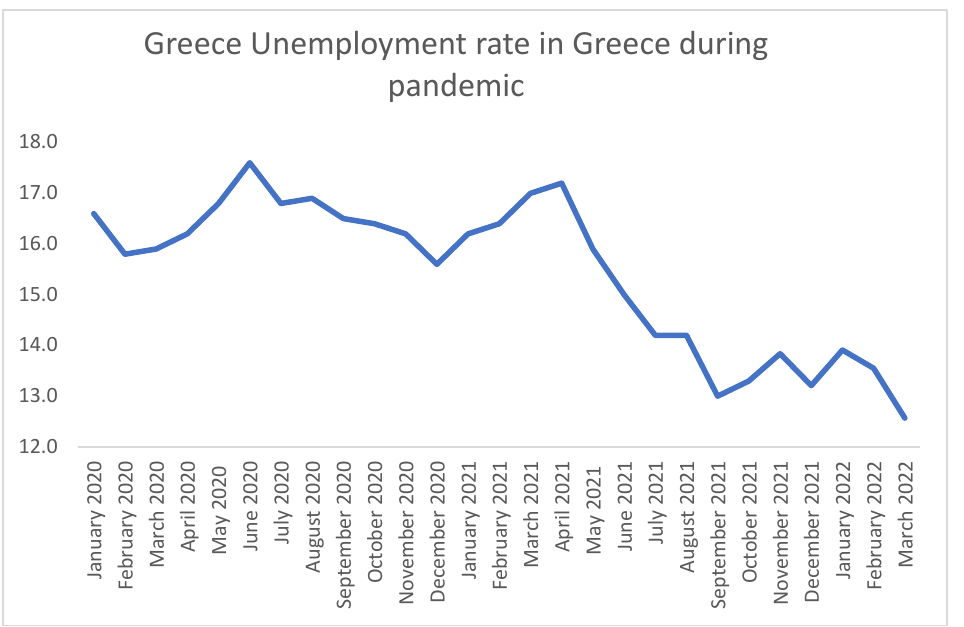
Figure 1. Unemployment rate in Greece during the pandemic crisis. Source: Eurostat.